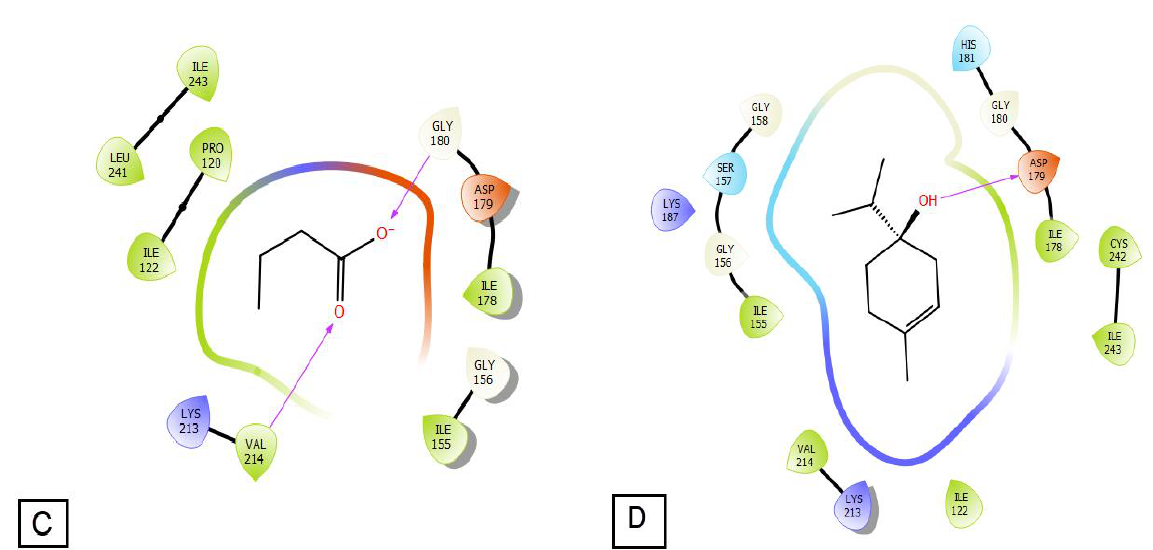
Molecules 2022 , 27 , x FOR PEER REVIEW Figure 3. 2D diagrams of ligands interactions with the active site of NADPH. ( A ) Thujone; ( B ) o-Cymene; ( C ) Butanoic acid; ( D ) Gamma-terpinene.